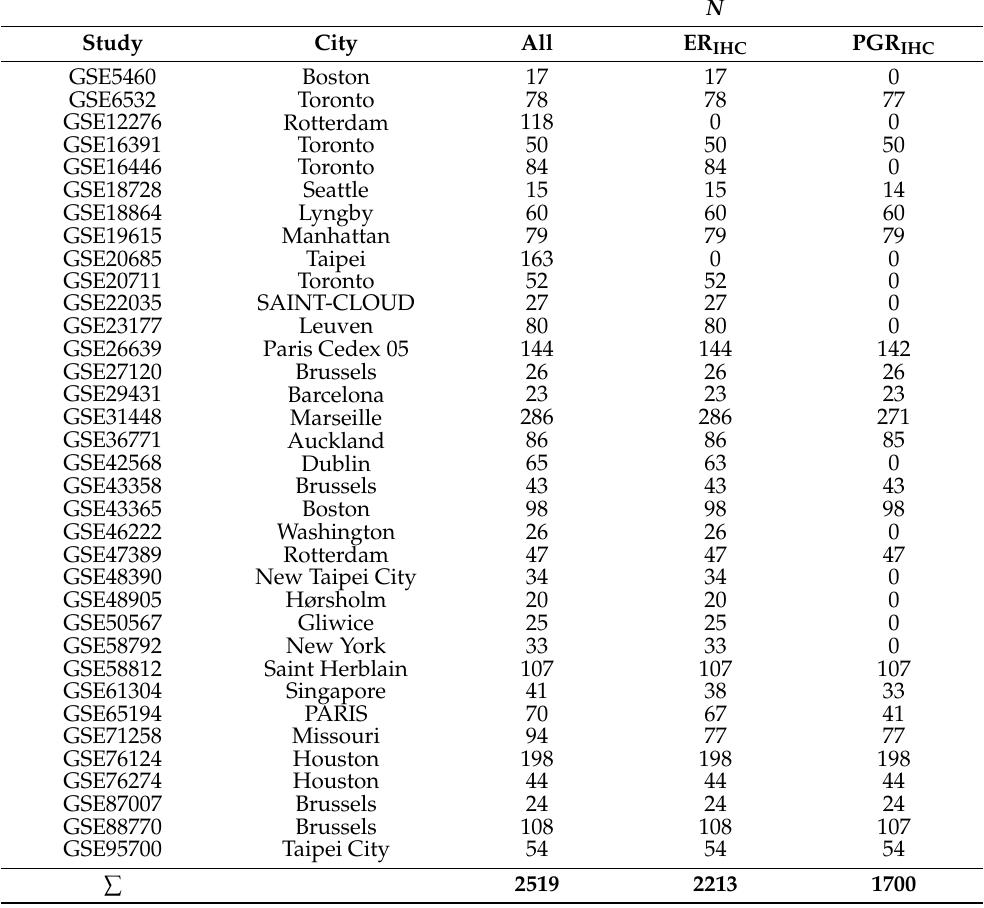
Table A1. Microarray studies used. N : number of samples. All: total number of samples in study. ER IHC : number of samples with IHC measurement of estrogen receptor status. PGR IHC : likewise for progesterone. For reference see also our previous work [37,59,99].